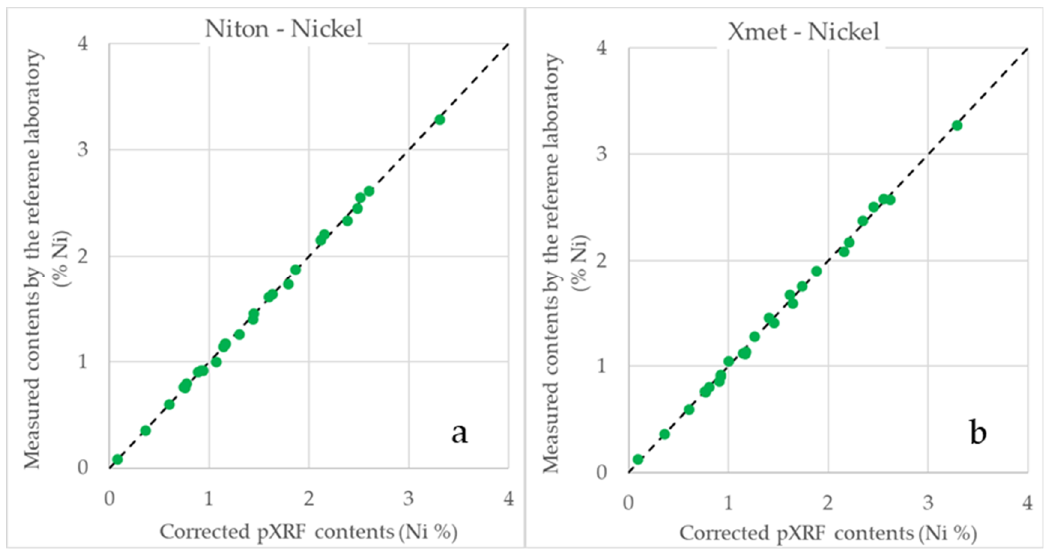
Figure 8. Results from multiple linear regression corrections for Ni, ( a ) for the Niton device and ( b ) for the Xmet device.